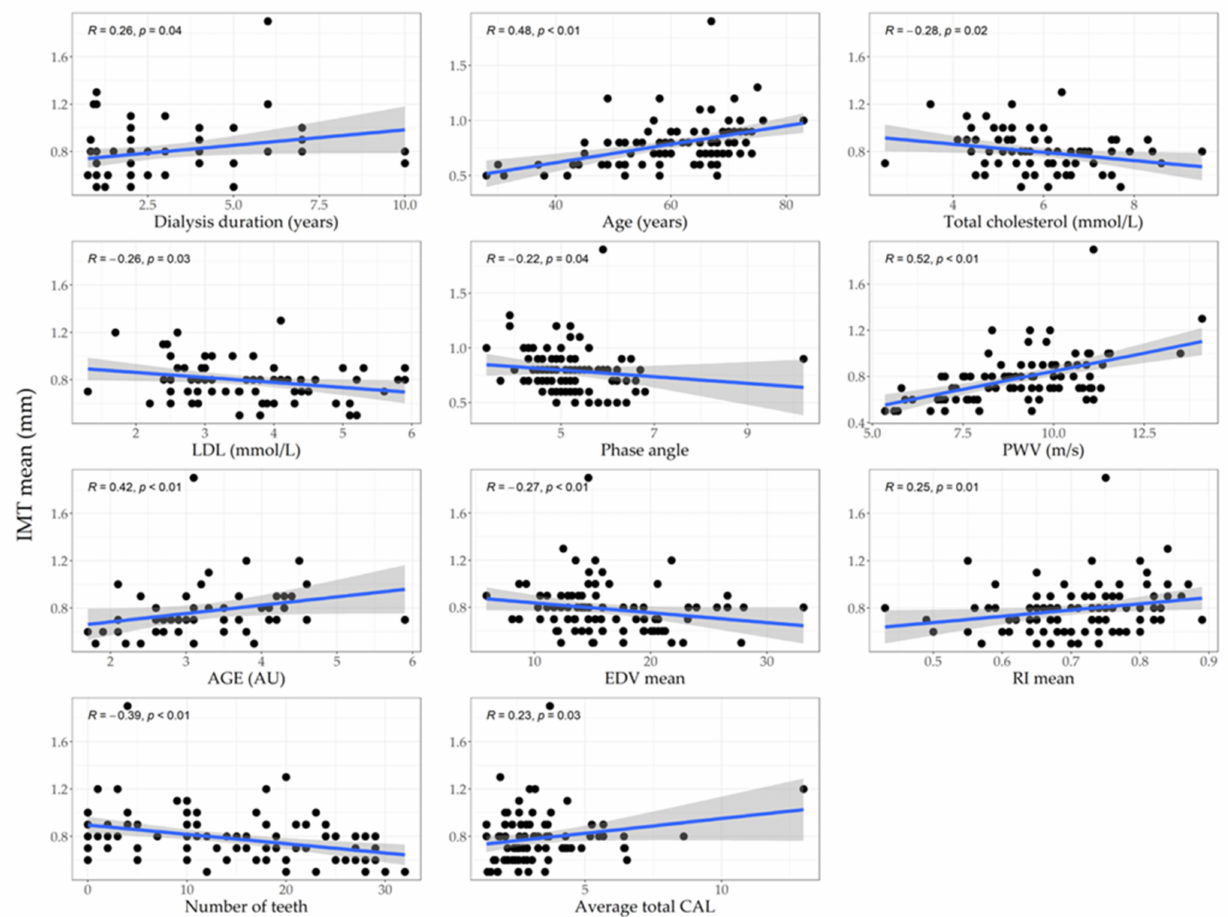
Figure 2. Correlations between IMT and measured parameters. Abbreviations: IMT, intima-media thickness; LDL, low-density lipoprotein cholesterol (mmol/L); PWV, pulse wave velocity (m/s); AGE, advanced glycation end-products (AU); EDV, end-diastolic velocity; RI, resistive index; CAL, clinical attachment